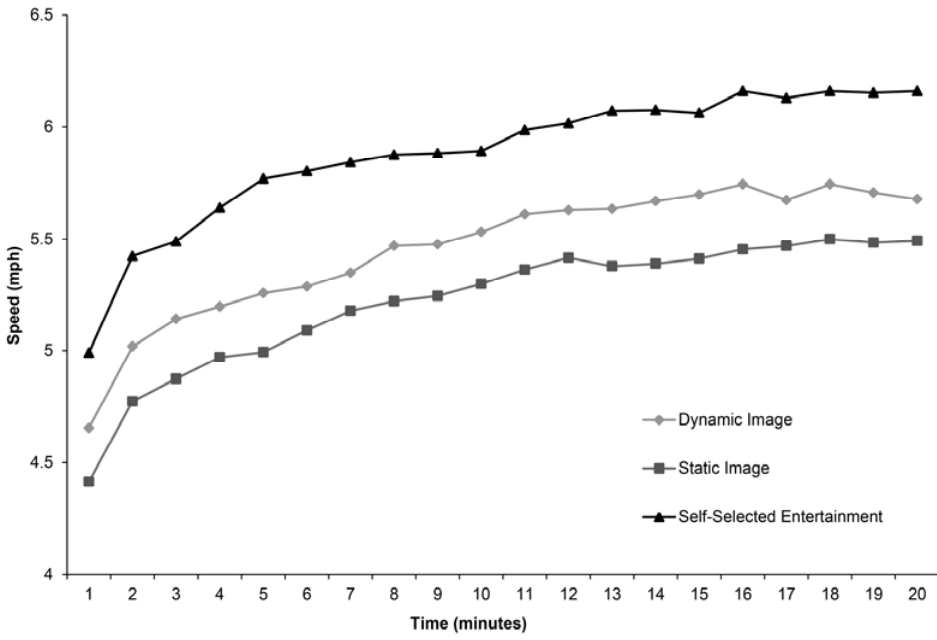
Figure 2. The mean minute-by-minute running speed in the three different conditions.